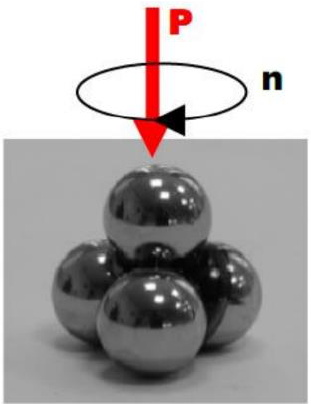
Figure 3. Diagram of a friction linkage in a 4-ball tester.